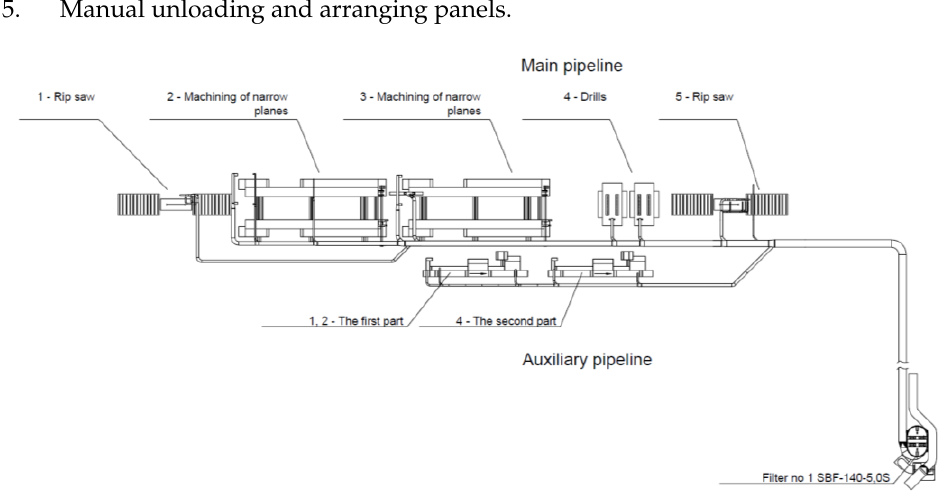
Figure 1. Scheme of the narrow surface treatment line.